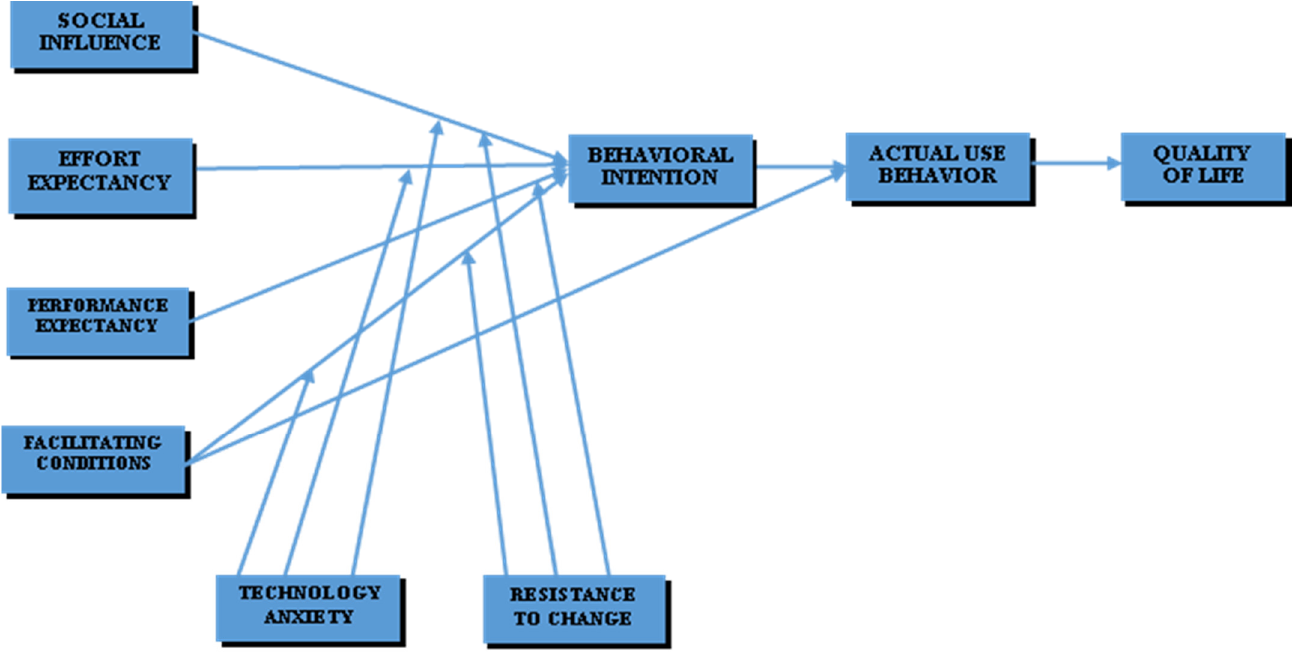
Figure 1. Conceptual framework.